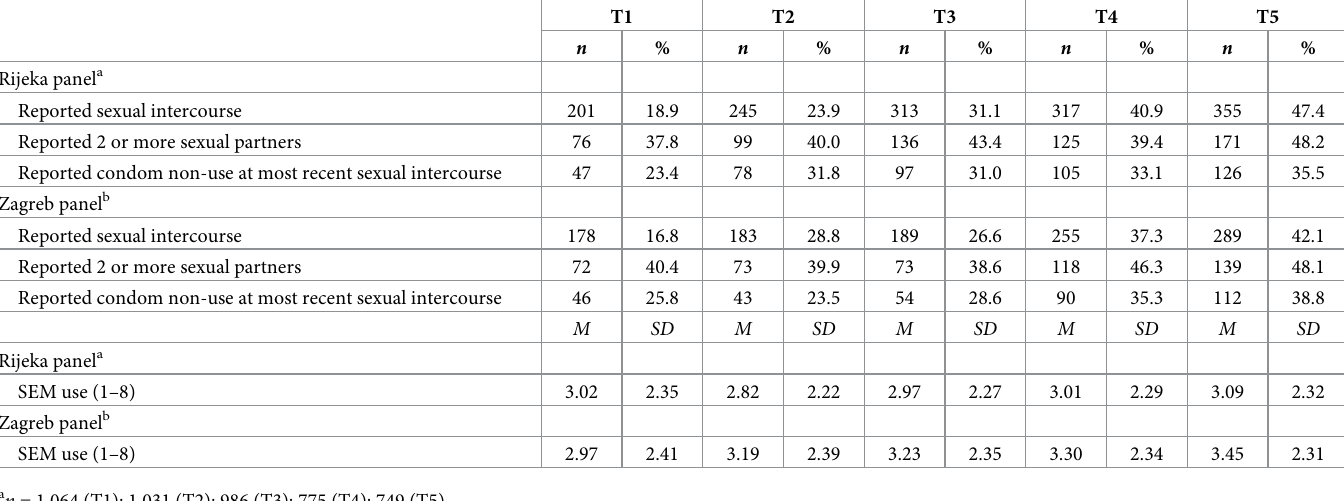
Table 1. Key sexual behaviors by wave and panel sample.